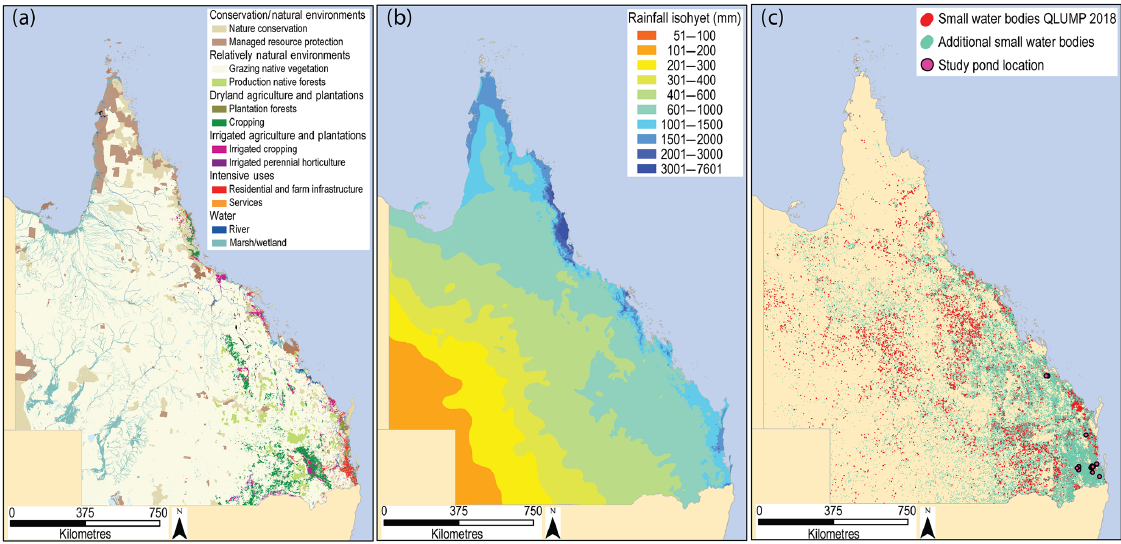
Figure 2. (a) The 2018 statewide assessment showing the relative surface area occupied by secondary land use categories (QLUMP, 2018). Note the legend shows the two largest land uses within each category. (b) Mean annual rainfall isohyets across Queensland from the 30-year period of 1961 to 1990 (http://www.bom.gov.au, last access: 13 March 2018). (c) Location of study ponds and ponds identified from the land use assessment (QLUMP, 2018) and two additional statewide databases (see